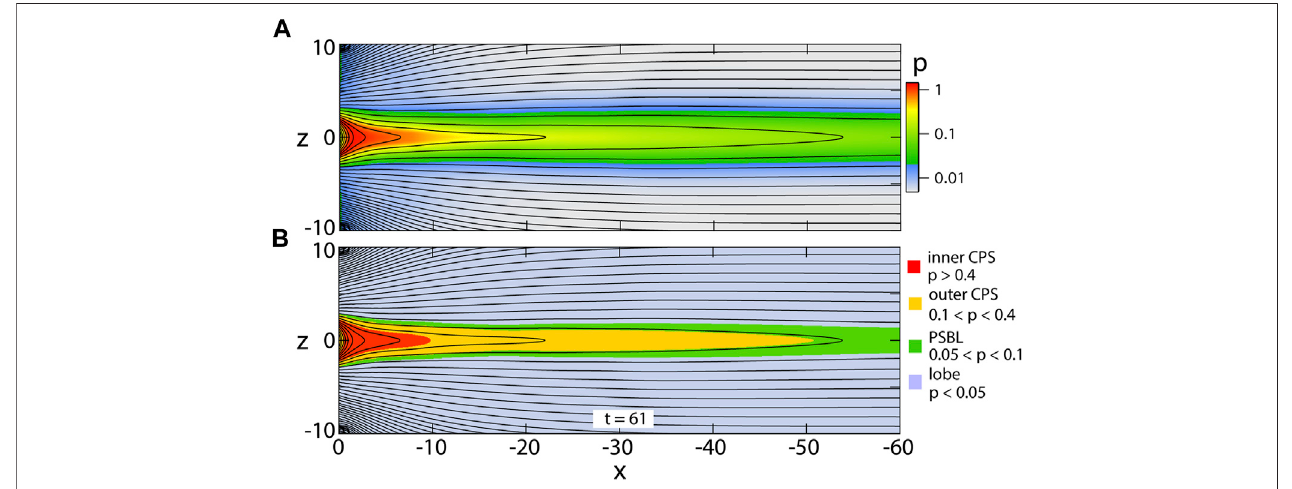
FIGURE 1 | Initial state after completion of the driving period, (A) magnetic fl ux contours and pressure (color) in the x , z plane at t = 61; (B) characteristic source regionsde fi nedbytheinitialpressureasindicatedintherightmargin:innercentralplasmasheet(CPS),outercentralplasmasheet,plasmasheetboundarylayer(PSBL), and lobe.